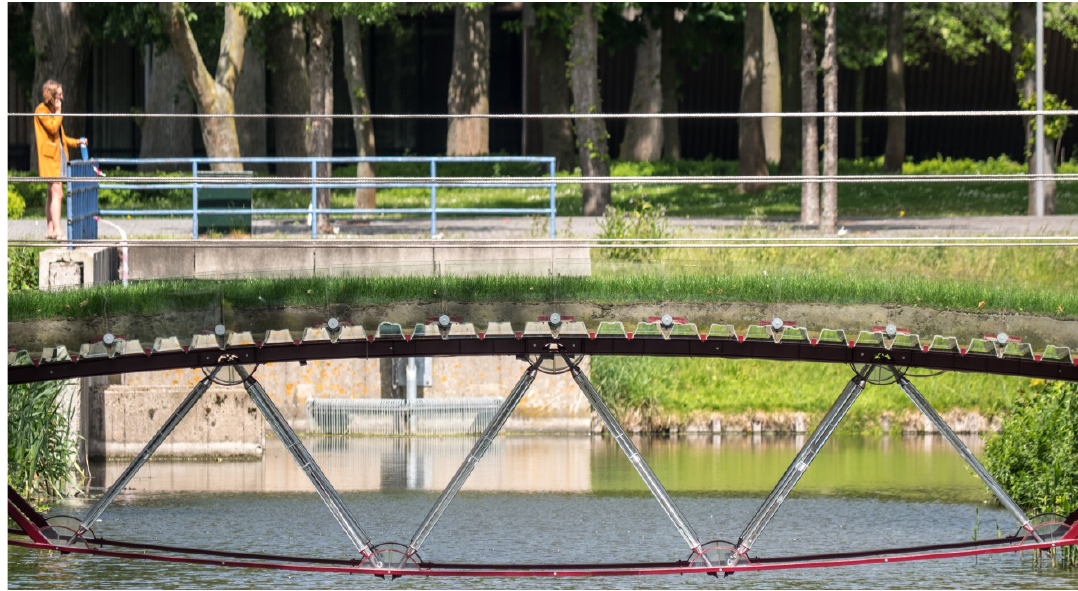
Fig. 2 photo of the glass truss bridge.